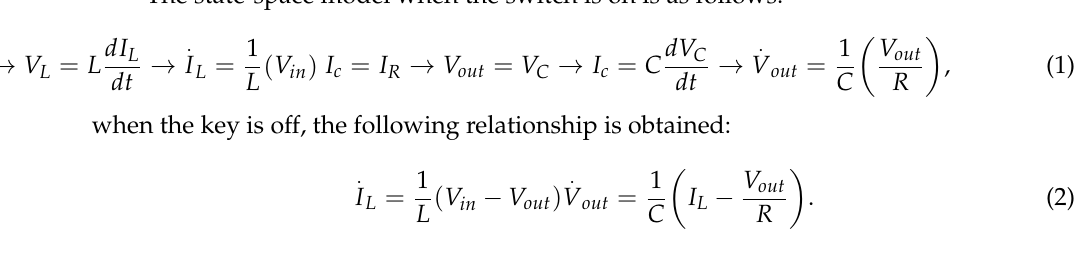
Figure 1. DC–DC boost converter.